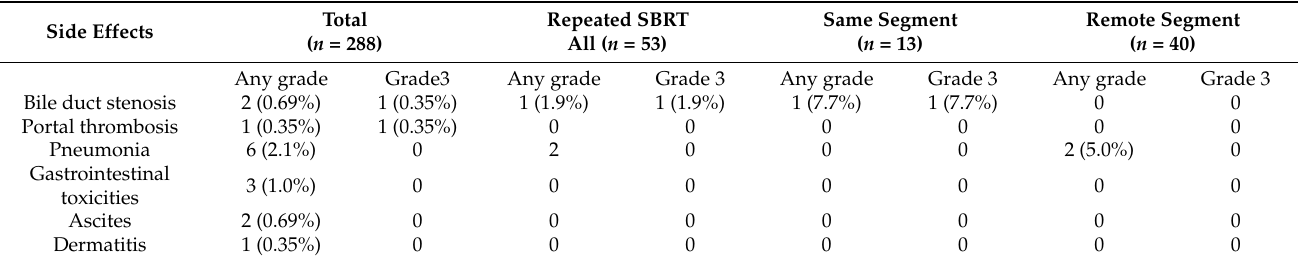
same-segment group ( n = 13) and remote-segment group ( n =